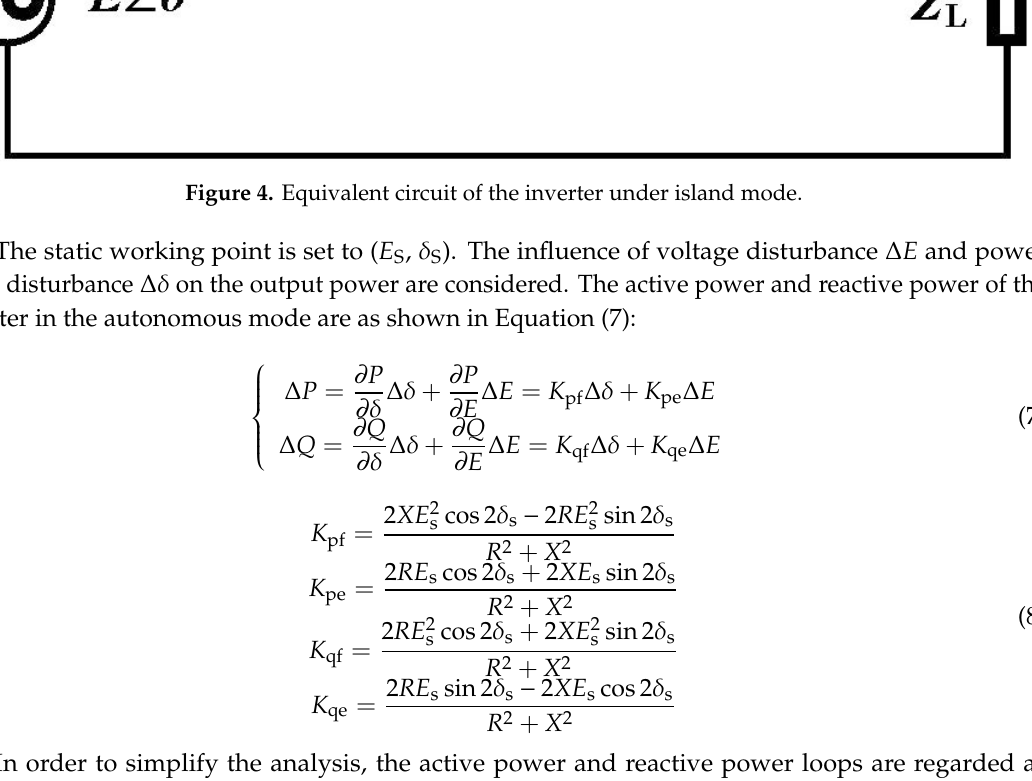
linearization of the time domain equation are carried out. Then, the Laplace change of the linearized time domain equation is carried out. The small-signal model of VSG in the s domain is obtained. According to the parameter design method in literature [23], the parameters of VSG control system are given in Table